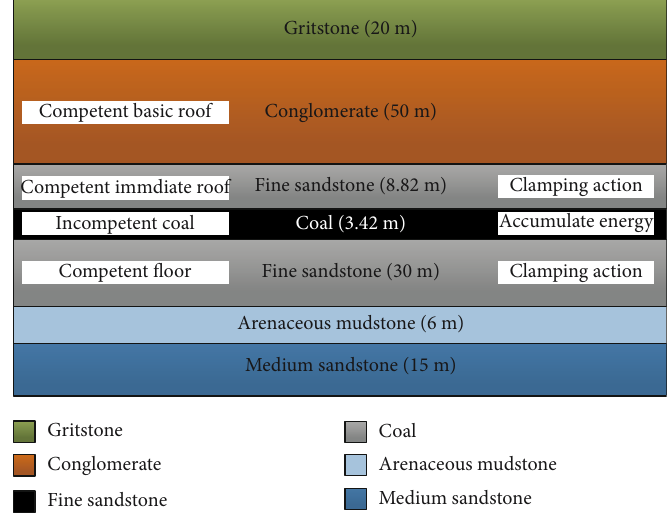
Figure 16: 106 Schematic diagram of the roof and fl oor of the working face.